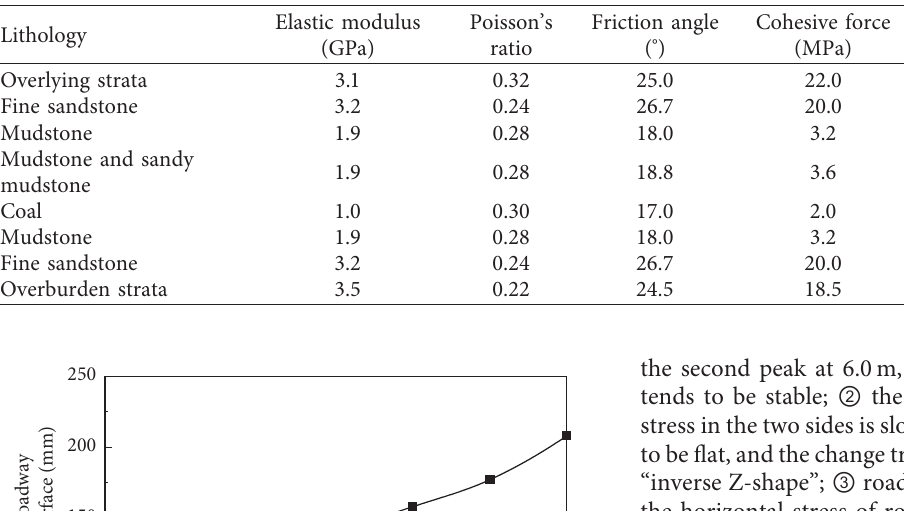
Table 1: Mechanical parameters of rock mass.